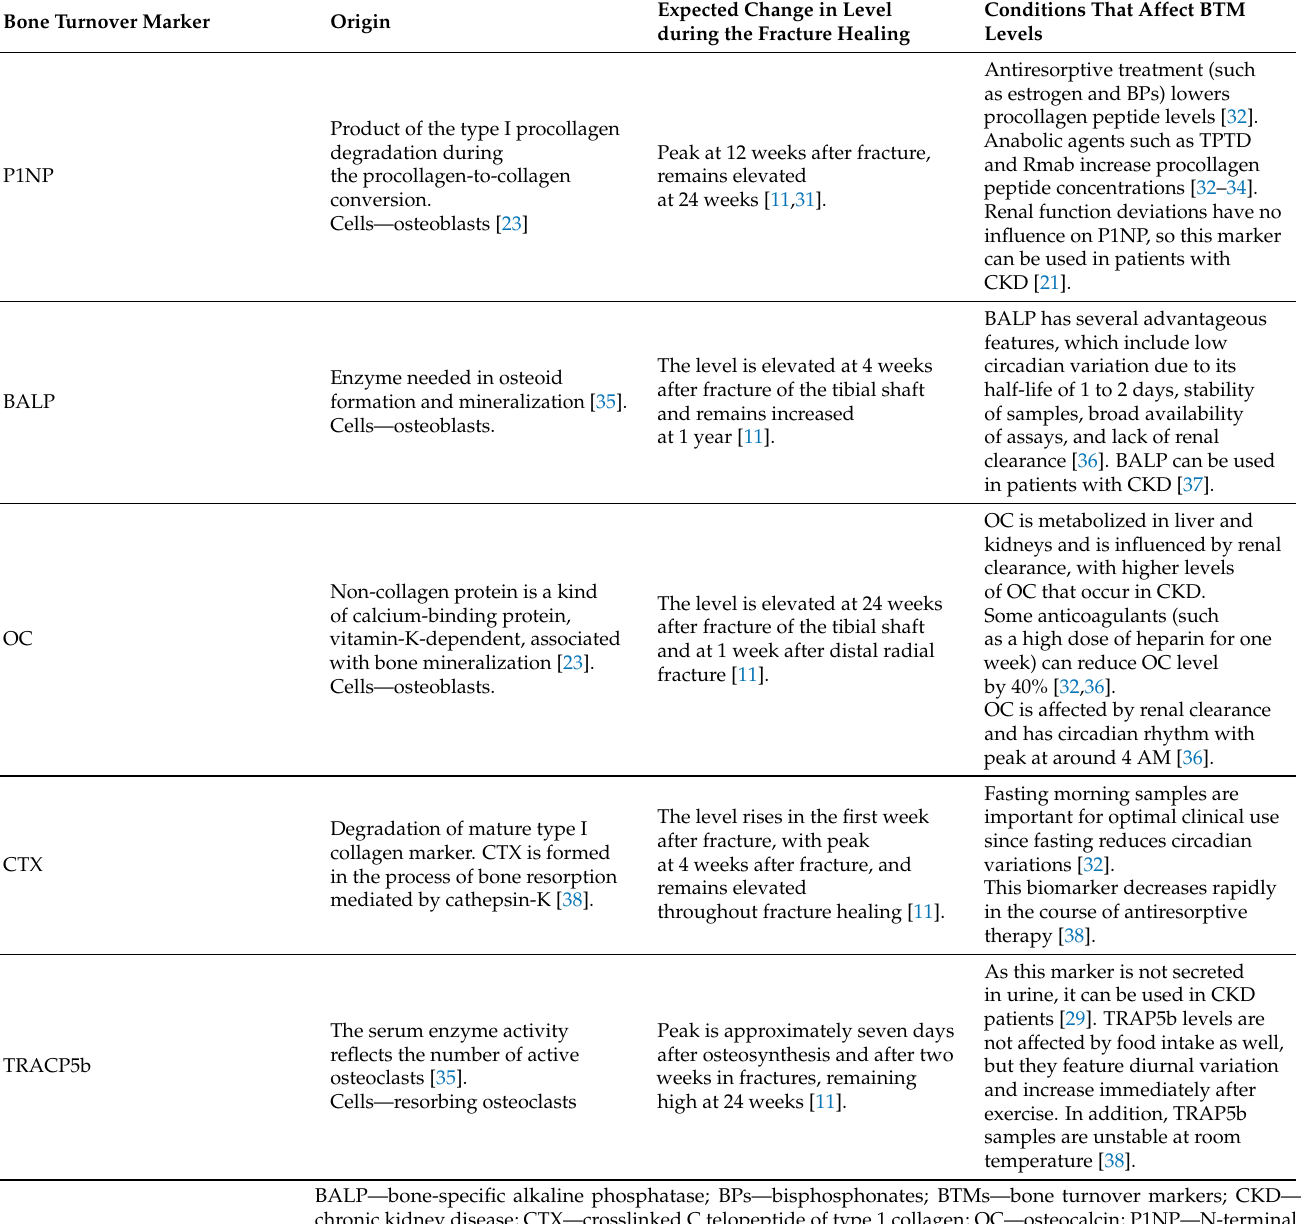
Table 1. Bone turnover markers, their activity in fracture healing, and limitations of BTMs